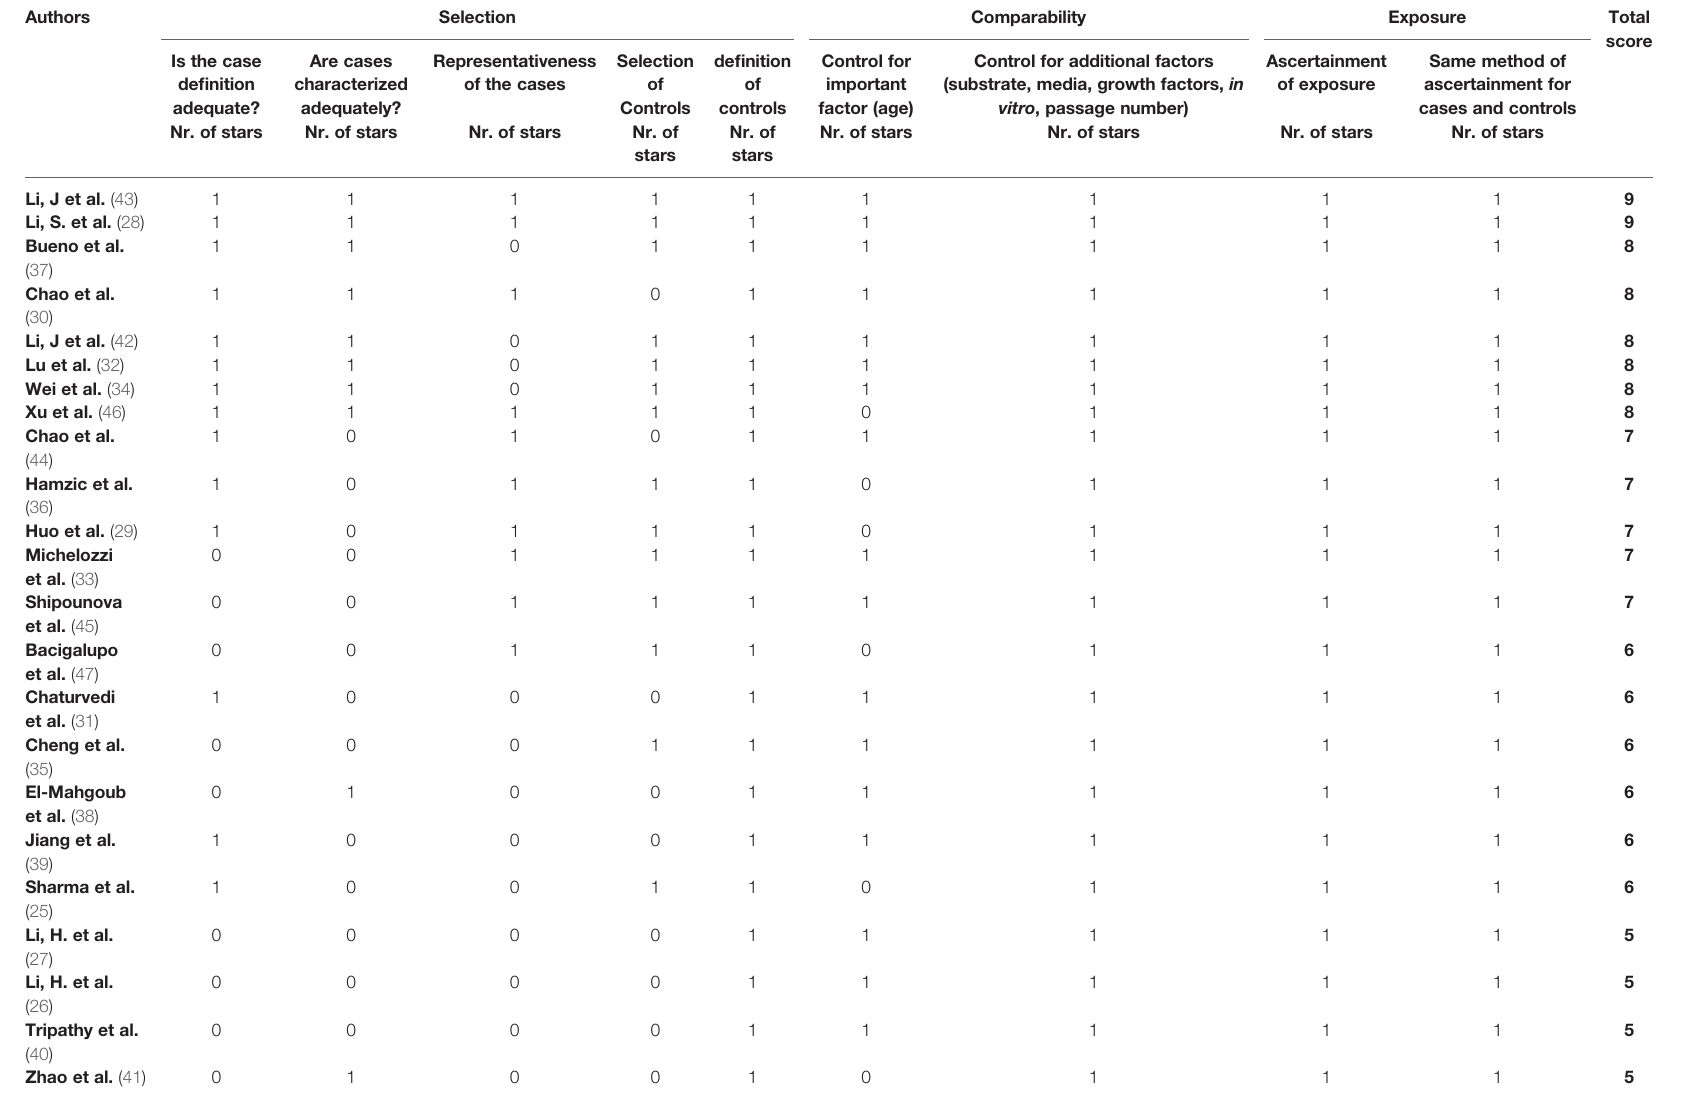
Bold values indicate the total number after adding up all the scores for each individual question in each individual